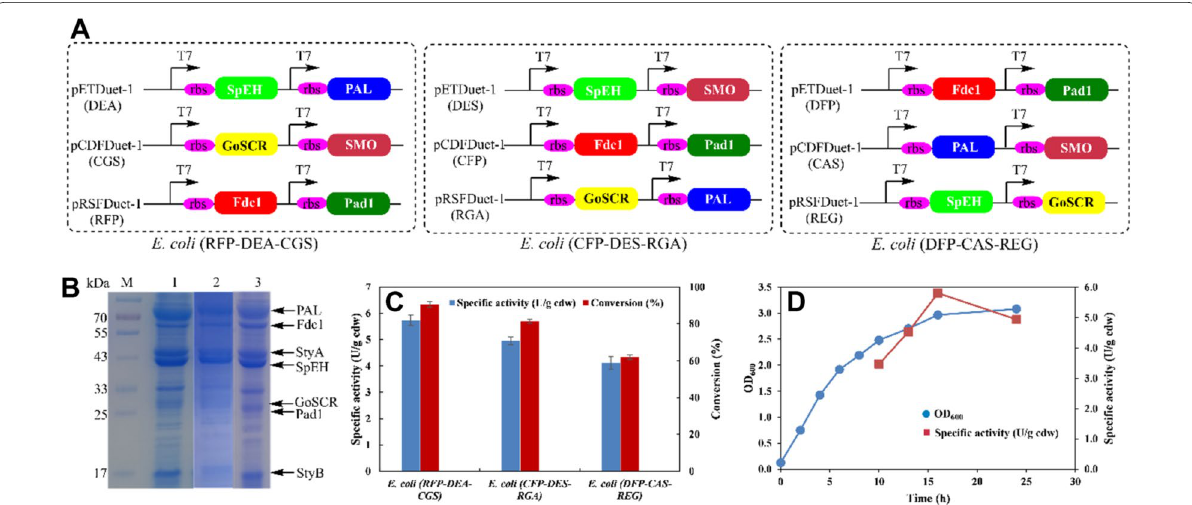
Fig. 1 Construction of recombinant E. coli cells co-expression of six enzymes for conversion of L-PA 1 to 2-HAP 6 . A Construction of recombinant E. coli cells co-expression of six enzymes based on different plasmid configurations. B SDS-PAGE analysis of recombinant E. coli cells. M: marker; lane 1: cell-free extract of E. coli (RFP-DEA-CGS), lane 2: cell-free extract of E. coli (CFP-DES-RGA); lane 3: cell-free extract of E. coli (DFP-CAS-REG). C Activities of three different recombinant E. coli cells for conversion of L-PA 1 to 2-HAP 6 . D Cell growth and specific activity of E. coli (RFP-DEA-CGS) for conversion of L-PA 1 to 2-HAP 6